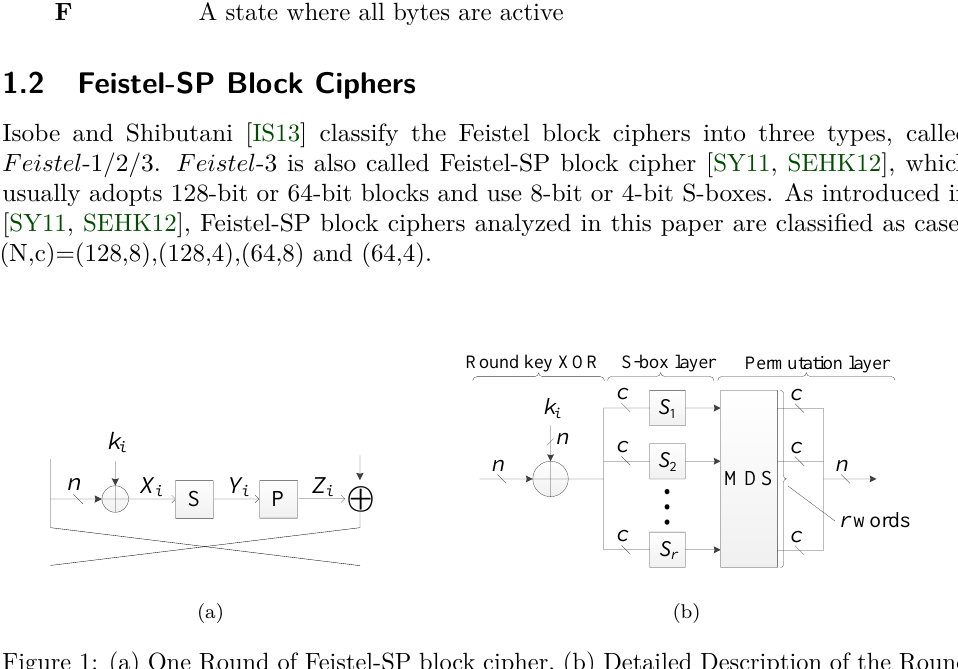
Figure 1: (a) One Round of Feistel-SP block cipher, (b) Detailed Description of the Round